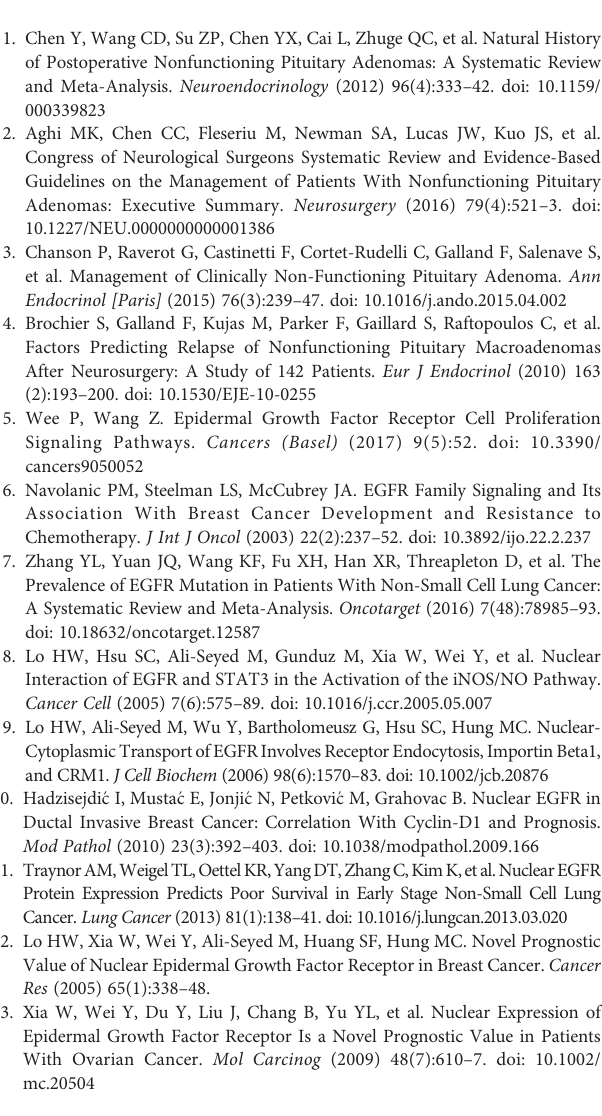
Supplementary Figure 1 | Flow diagram of NFPAs recruited in the study. Supplementary Figure 2 | pEGFR T693 overexpressed in proliferative NFPAs. Quantitative h-score of pEGFR T693 immunohistochemistry with clinical